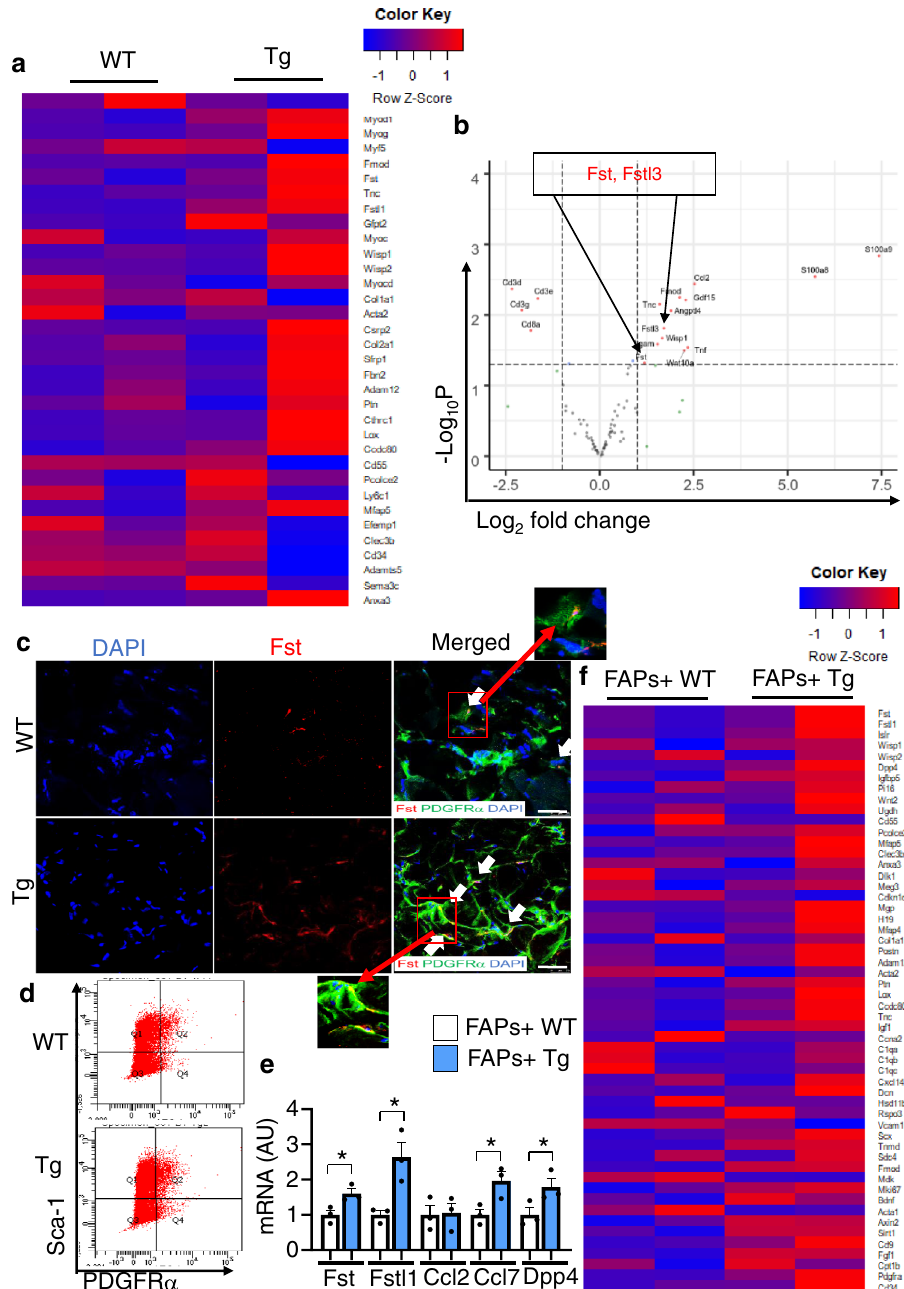
Fig. 2 | Depletion of CD206 + M2-like M Φ enhances expression of myogenesis- related marker genes and FAPs-related marker genes. a Total RNA sequencing (RNA-Seq) analysis of tibialis anterior (TA) of Tg mice and control WT following acute injury. Heatmap of RNA-Seq expression data showing the most signi fi cantly altered FAPs-related marker genes in Tg mice, compared with littermate control WT mice ( n =2 mice per group). b Volcano plot analysis highlights the most sig- ni fi cant gene alterations in Tg mice versus control WT mice based on false dis- covery rate threshold (red) [FDR q value<0.05 and − 0.58>Log 2 fold change (FC)>0.58] and P value threshold (green) [ P value<0.05 and − 0.58>Log 2 fold change (FC)>0.58]. Highlighted in gray are the fi ltered non-signi fi cant changes, as indicated. The red dots represent genes that were signi fi cantly upregulated/ downregulated in the muscle of Tg mice. The Y -axis denotes the − Log 10 P values, whilethe X -axisshowstheLog 2 foldchangevalues.Thevolcanoplotwasgenerated